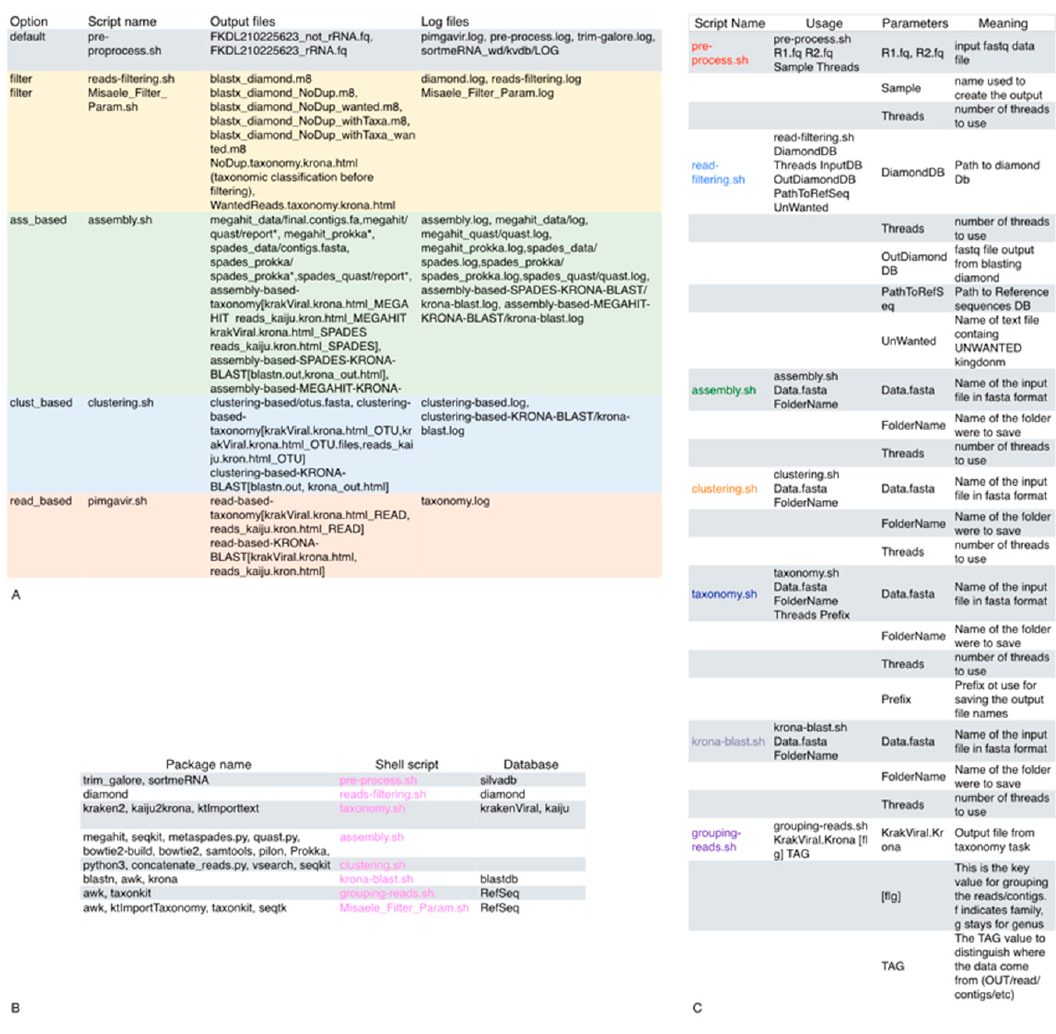
Figure 2. PIMGAVir scripts. ( A ) Table showing some of the results and log files produced by every strategy and the invoked script. ( B ) Table reporting the databases and the packages used by every script. ( C ) Table containing the list of scripts used in PIMGAVir and its parameters.